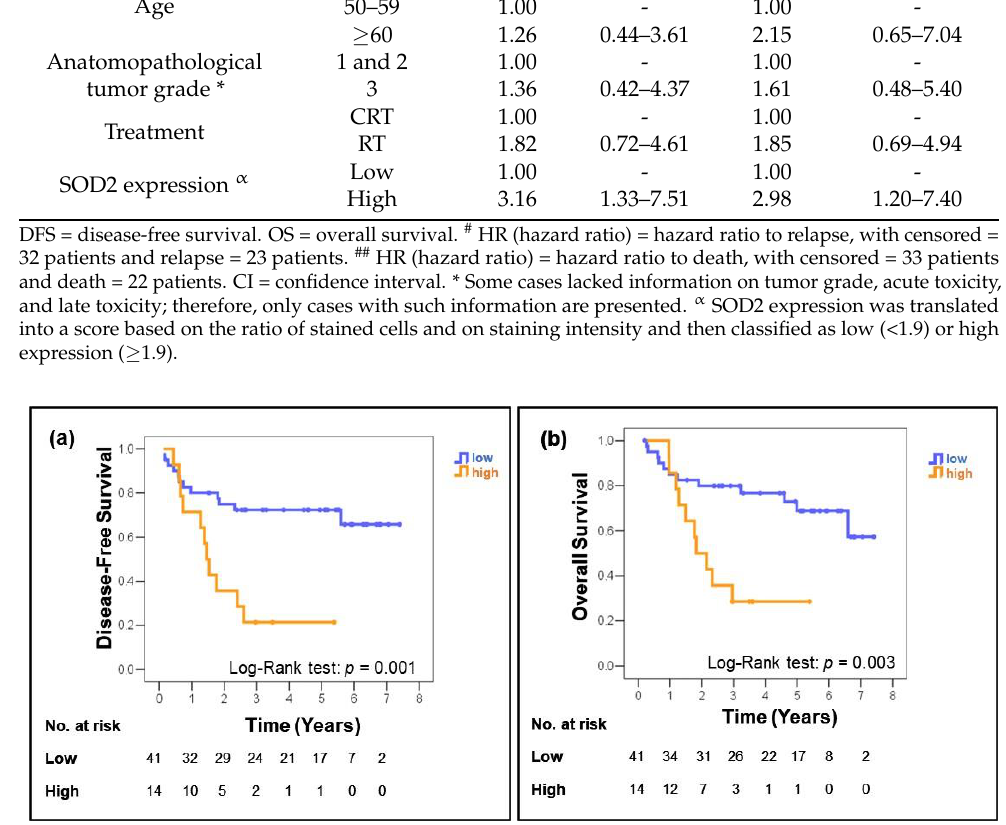
Figure 2. Disease-free ( a ) and overall ( b ) survival rates of the groups categorized by superoxide dismutase (SOD2) expression in a cohort of patients with squamous cervical cancer. SOD2 expression was translated into a score based on the ratio of stained cells and staining intensity and then classified as low (<1.9) or high expression (≥1.9). A high expression of SOD2 was associated with a trend toward a shorter disease-free survival ( p = 0.001) and was correlated significantly with poor overall survival ( p = 0.003) in squamous cervical